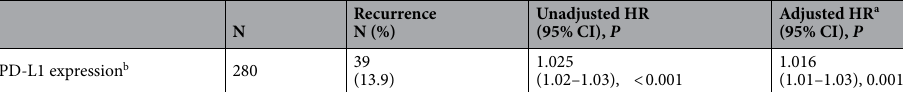
Table 3. Cox proportional hazards analysis of RFS according to the PD-L1 expression as a continuous variable. RFS recurrence-free survival, PD-L1 programmed death-ligand 1, HR hazard ratio, CI confidence interval, EGFR epidermal growth factor receptor gene. a Adjusted by pathological stage, histological type, adjuvant chemotherapy, EGFR mutation status and sex. b The tumor proportion score (%) was as a continuous variable from 0 to